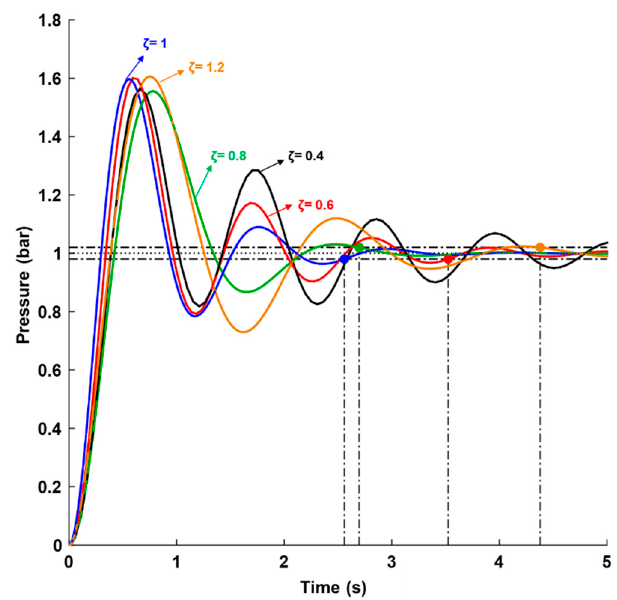
Figure 5. Unit step response at various damping ratios for the PID control algorithm.